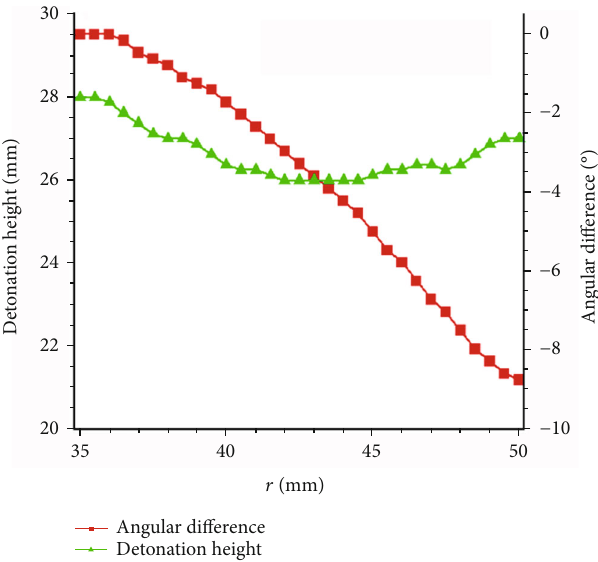
Figure 7: Variation of detonation height and angular di ff erence ( H = 15 mm).